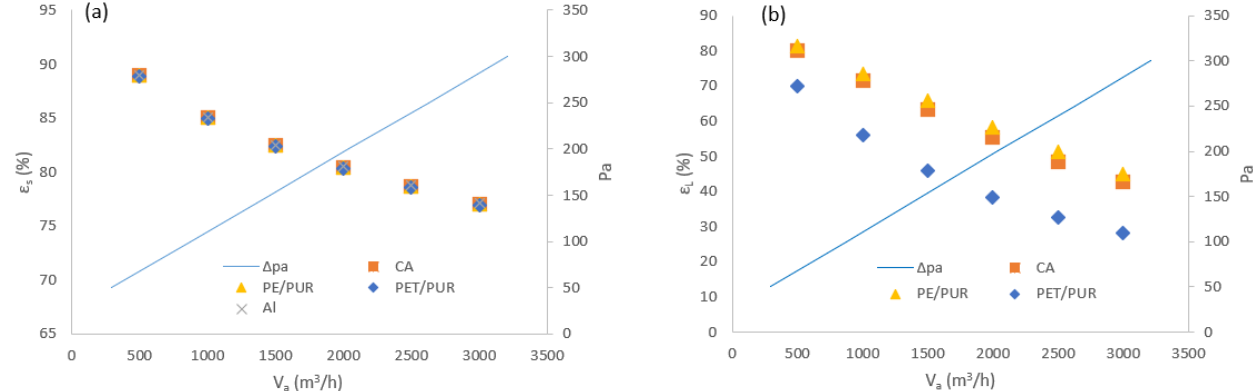
Figure 12. Effectiveness of exchanger cores under a variable airflow and a uniform membrane thickness of 20 µm. ( a ) Sensible effectiveness; ( b ) Latent effectiveness.